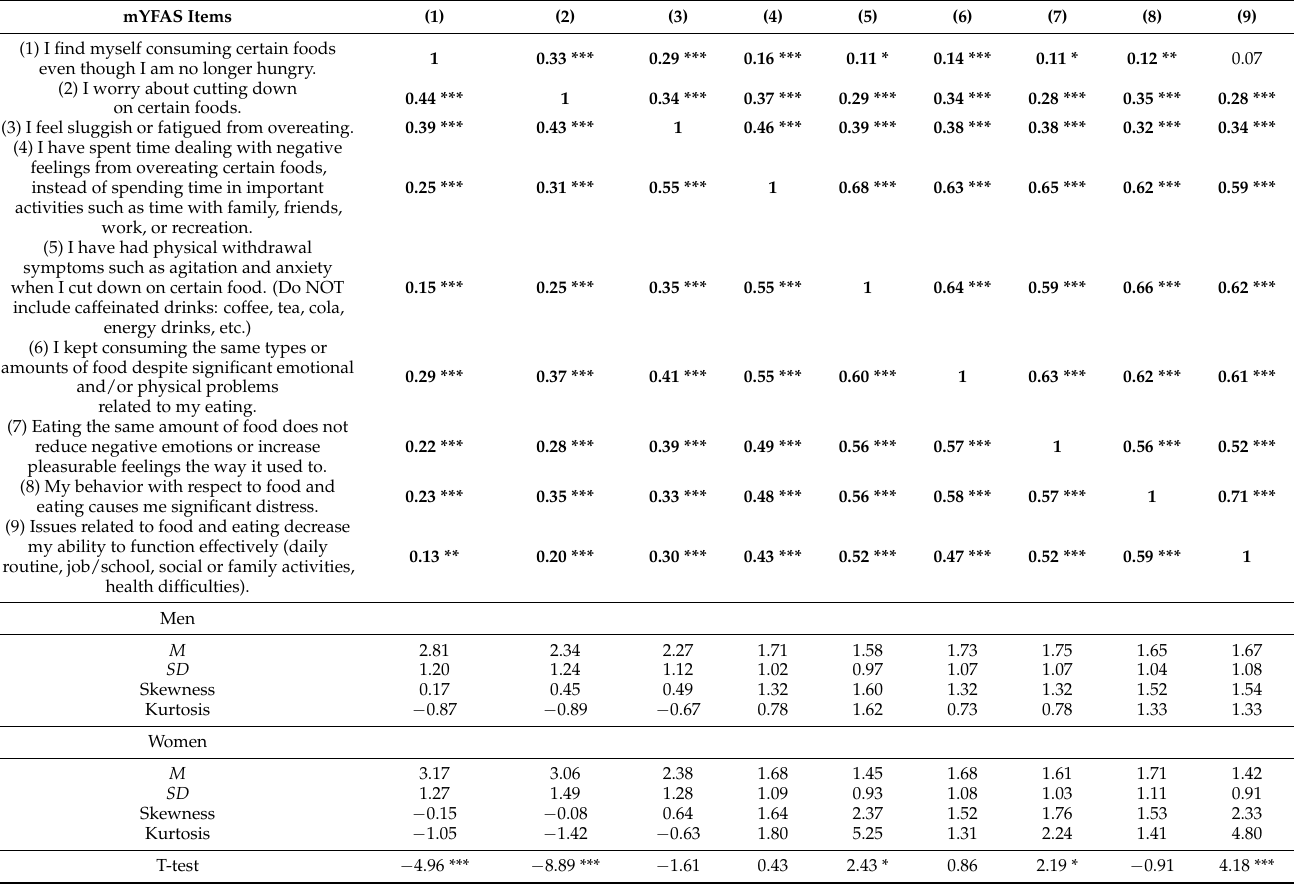
Table 1. Descriptive statistics and bivariate correlations for the mYFAS items among men (above the diagonal; n = 546) and women (below the diagonal; n =